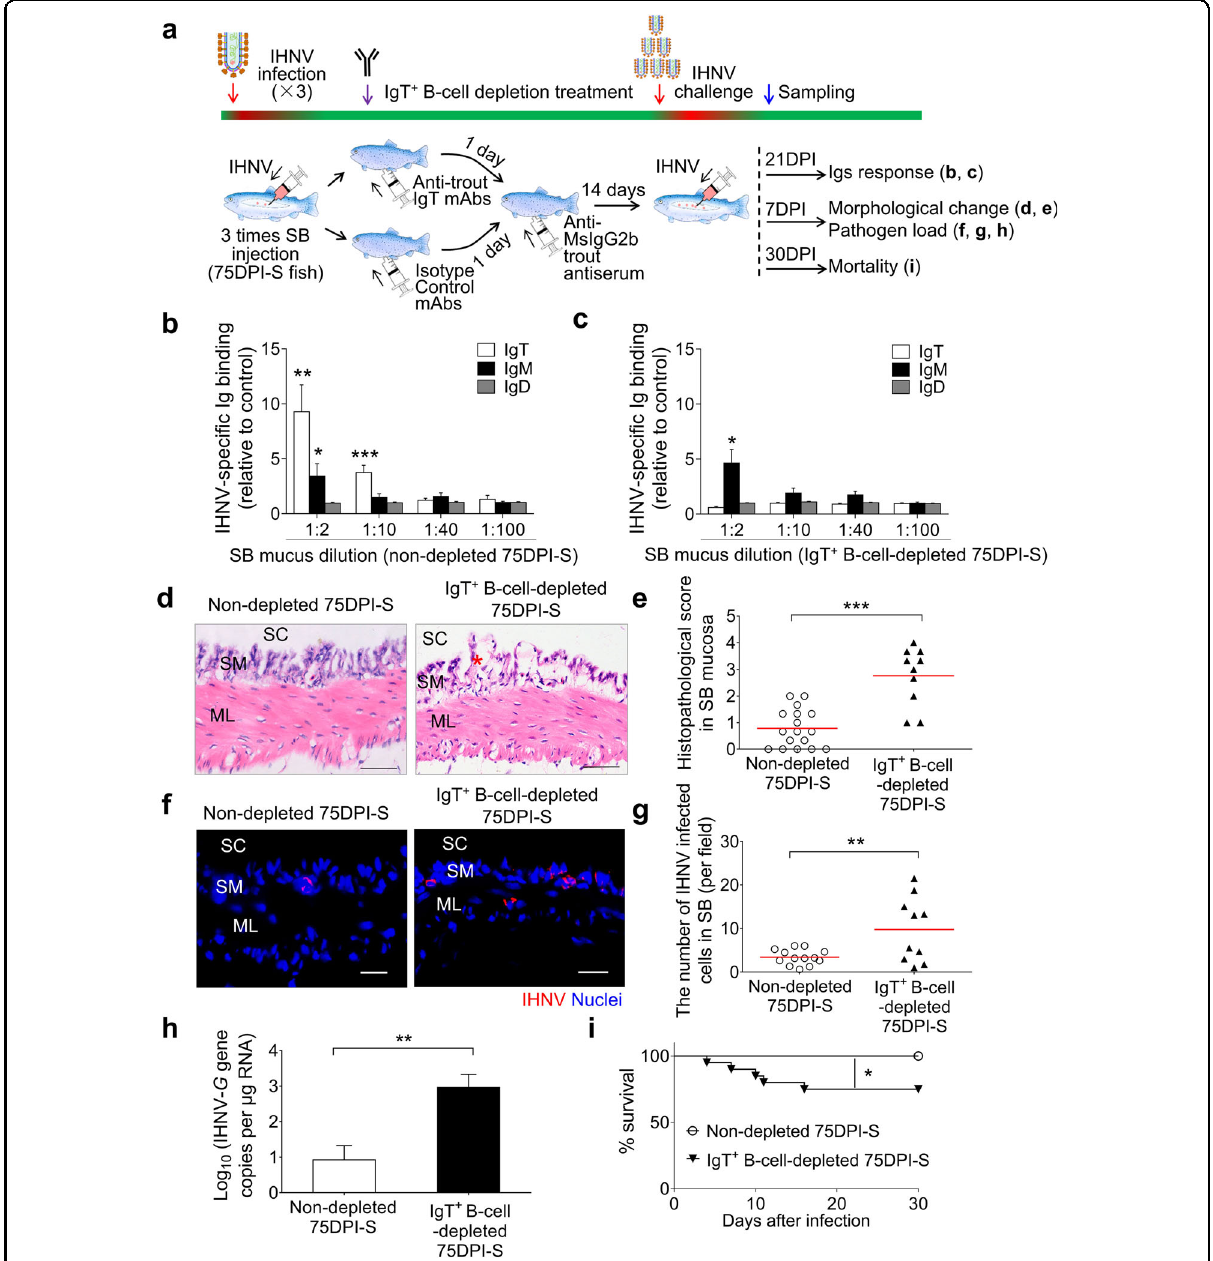
Fig. 7 IgT + B-cell depletion in fi sh signi fi cantly increases SB viral load and fi sh mortalities upon IHNV infection. a Scheme of the experimental strategy. Brie fl y, immune fi sh ( fi sh that survived monthly IHNV infections via SB injection, during a 3-month period (75DPI-S fi sh)) were injected with either isotype (mouse IgG2b) control Abs (non-depleted 75DPI-S fi sh) or anti-IgT mAb (IgT + B-cell-depleted 75DPI-S fi sh). One day later, fi sh were injected with anti-mouse IgG2b trout antiserum. At 14 days after trout antiserum injection, the non-depleted 75DPI-S and IgT + B-cell-depleted 75DPI-S groups were infected by intra-SB injection with IHNV (25 μ L, 1×10 7 TCID 50 ), and at 21, 7, and 30 DPI, the two fi sh groups were analyzed for Ig responses, morphological SB changes and SB viral load, and mortalities, respectively. b , c IgT-, IgM-, and IgD-speci fi c binding to IHNV in dilutions of SB mucus from non-depleted ( b ) and IgT + B-cell-depleted ( c ) 75DPI-S fi sh at 21 DPI. Results are presented as relative values to those of the SB mucus from uninfected naive fi sh ( n = 8 – 12). d H&E staining of trout SB from non-depleted and IgT + B-cell-depleted 75DPI-S fi sh at 7 DPI. Red asterisk indicates the damage in SM. Scale bars, 50 μ m. SC SB cavity, SM SB mucosa, ML muscle layer. e Pathology score of SB mucosa in non-depleted and IgT + B-cell-depleted 75DPI-S fi sh at 7 DPI. f IHNV protein was detected by anti-IHNV- N protein mAb (red) in SB mucosa from non-depleted (left) and IgT + B-cell-depleted (right) 75DPI- S fi sh at 7 DPI. Nuclei were stained with DAPI (blue). SC SB cavity, SM SB mucosa, ML muscle layer. Scale bars, 20 μ m. g The number of virally stained cells in SB mucosa of non-depleted and IgT + B-cell-depleted 75DPI-S fi sh upon challenge with IHNV counted from f . h Upon challenge, IHNV- G gene copies (Log10) was quanti fi ed using qPCR in SB from non-depleted and IgT + B-cell-depleted 75DPI-S fi sh at 7 DPI ( n = 10). i Cumulative survival of non- depleted and IgT + B-cell-depleted 75DPI-S fi sh infected with IHNV. Each symbol ( e , g ) represents an individual fi sh; small horizontal red lines ( e , g ) indicate the means. Statistical differences were evaluated by unpaired Student ’ s t -test ( b , c , e , g , h ) and log-rank (Mantel-Cox) test ( i ). Data are representative of at least three independent experiments (mean±SEM). * P < 0.05, ** P <0.01, and *** P